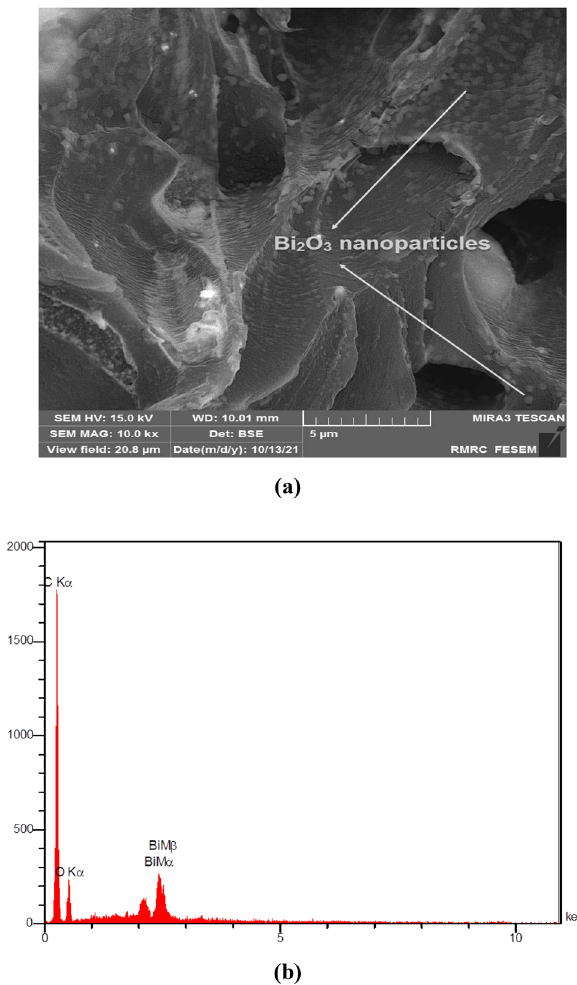
Figure 3. Illustration of ( a ) FESEM of the fractured surface, and ( b ) EDS analysis corresponding to the 50 wt% PC–Bi 2 O 3